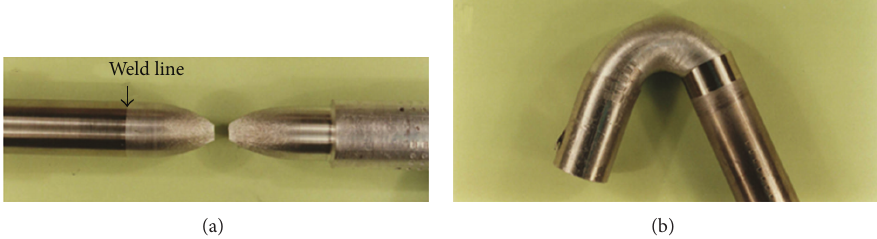
Figure 3: View of friction welded joints of 99.8 aluminium-X10CrNiTi189 austenitic steel, after the static tensile test (a) and the technological bending test (b).